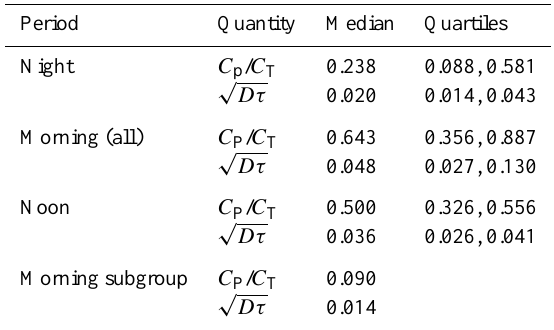
Table 6. Precipitated-to-trapped flux ratios, and corresponding dif- fusion parameters, for 30keV